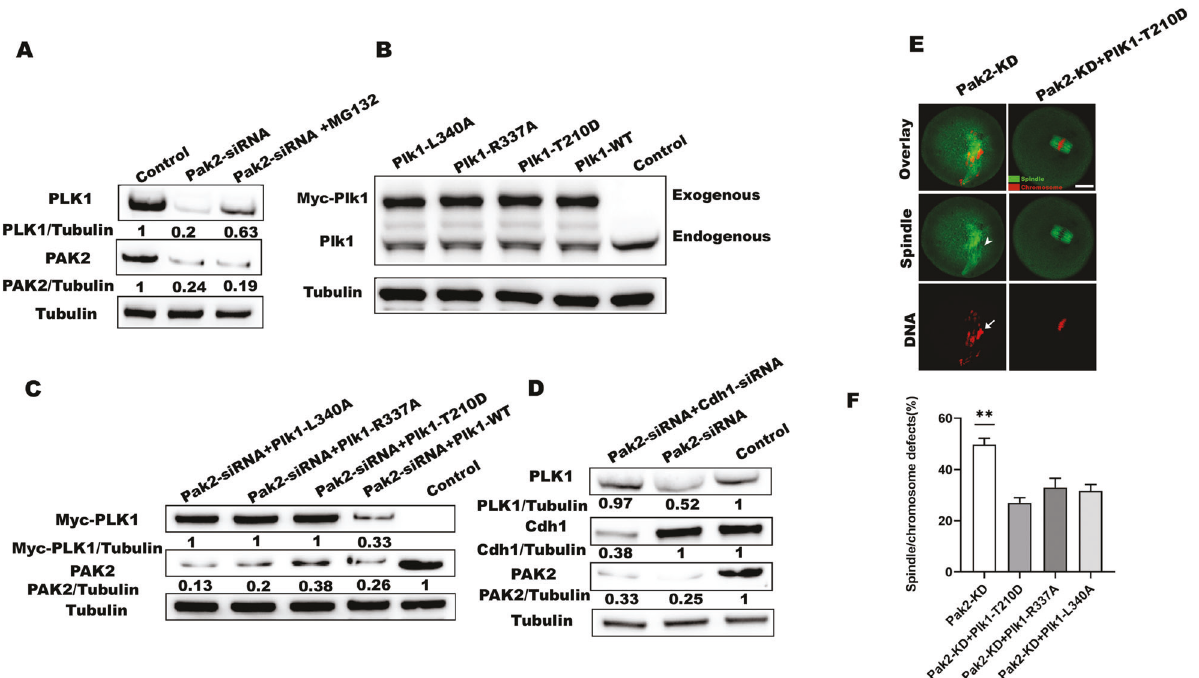
Fig. 6 PAK2 protects PLK1 from APC/C Cdh1 -mediated degradation. A PLK1 protein levels in control, Pak2 -KD, and Pak2 -KD + MG132 oocytes. The blots were probed with PAK2, PLK1 and tubulin antibodies. B Western blots show that the various mutant PLK1 proteins were expressed to a similar extent. The blots were probed with PLK1 and tubulin antibodies. C PLK1 protein levels in control, Pak2-KD + Plk1-L340A, Pak2- KD + Plk1-R337A, Pak2-KD + T210D and Pak2-KD + Plk1-WT oocytes. The blots were probed with Myc, PAK2 and tubulin antibodies. D PLK1 protein levels in control, Pak2 -KD, and Pak2 -KD + Cdh1 -KD oocytes. The blots were probed with PAK2, Cdh1, PLK1 and tubulin antibodies. E Pak2 -KD and Pak2 -KD + Plk1 -T210D oocytes were stained with α ‐ tubulin antibody to visualize the spindle (green) and counterstained with PI to observe chromosomes (red). Arrowheads indicate the misaligned chromosomes, and arrows indicate the defective spindles (scale bar, 20 μ m). F Quanti fi cation of Pak2 -KD, Pak2 -KD + Plk1 -T210D, Pak2 -KD + Plk1 -R337A and Pak2 -KD + Plk1 -L340A oocytes with spindle/ chromosome defects (49.7 ± 2.05%, n = 116; 27.0 ± 1.63%, n = 111; 33.0 ± 2.94%, n = 98; 31.7 ± 2.05%, n = 104; respectively). * p < 0.05 vs. controls. (scale bar, 20 μ m).